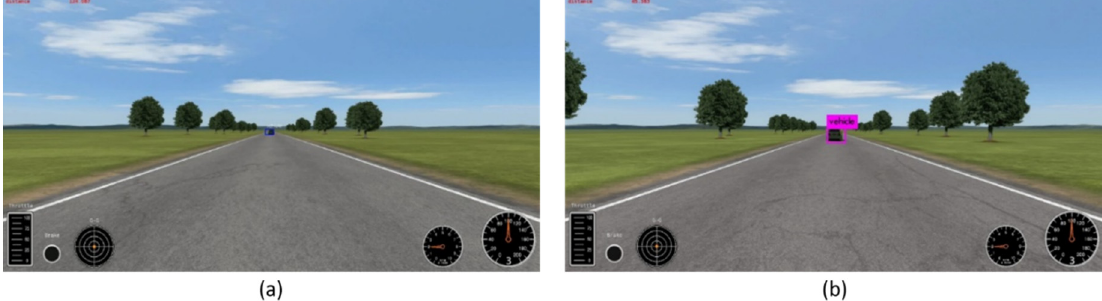
Figure 8. Detection results on CarSim simulation software. ( a ) the result of the proposed model, detecting a vehicle 124 m (intersection over union (IoU) > 0.5) and 200 m (IoU > 0.3) away. ( b ) the result of YOLOv2, detecting the vehicle within 45 m (IoU > 0.5).